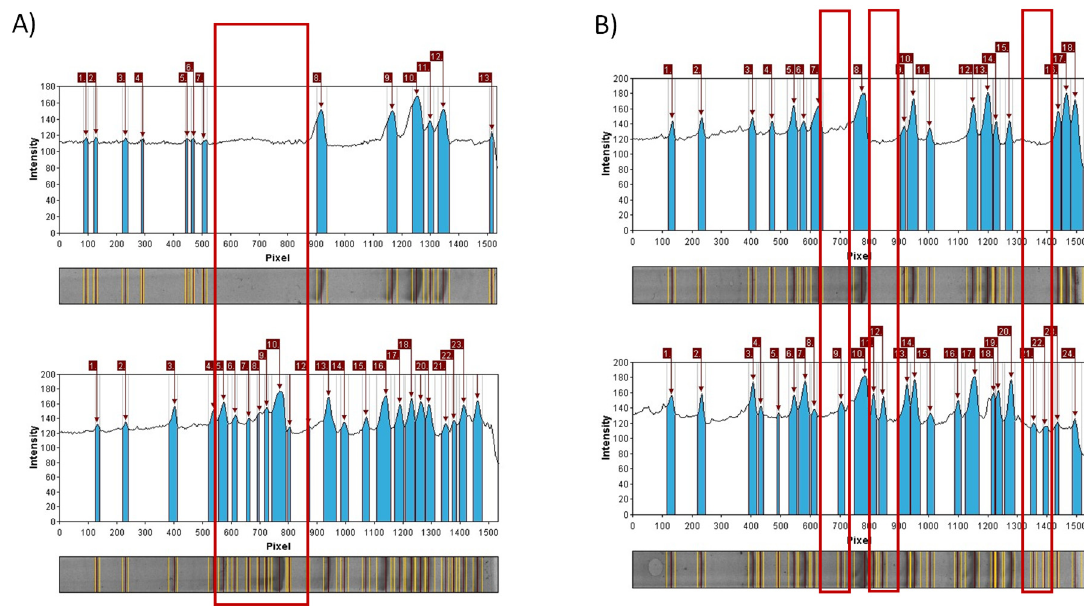
Figure 8. Obtained iPBS unique amplicons regions in Rosa canina var. lapidicola Heinr. Braun. (L) (down) for markers 2252 ( A ) and 2376 ( B ).